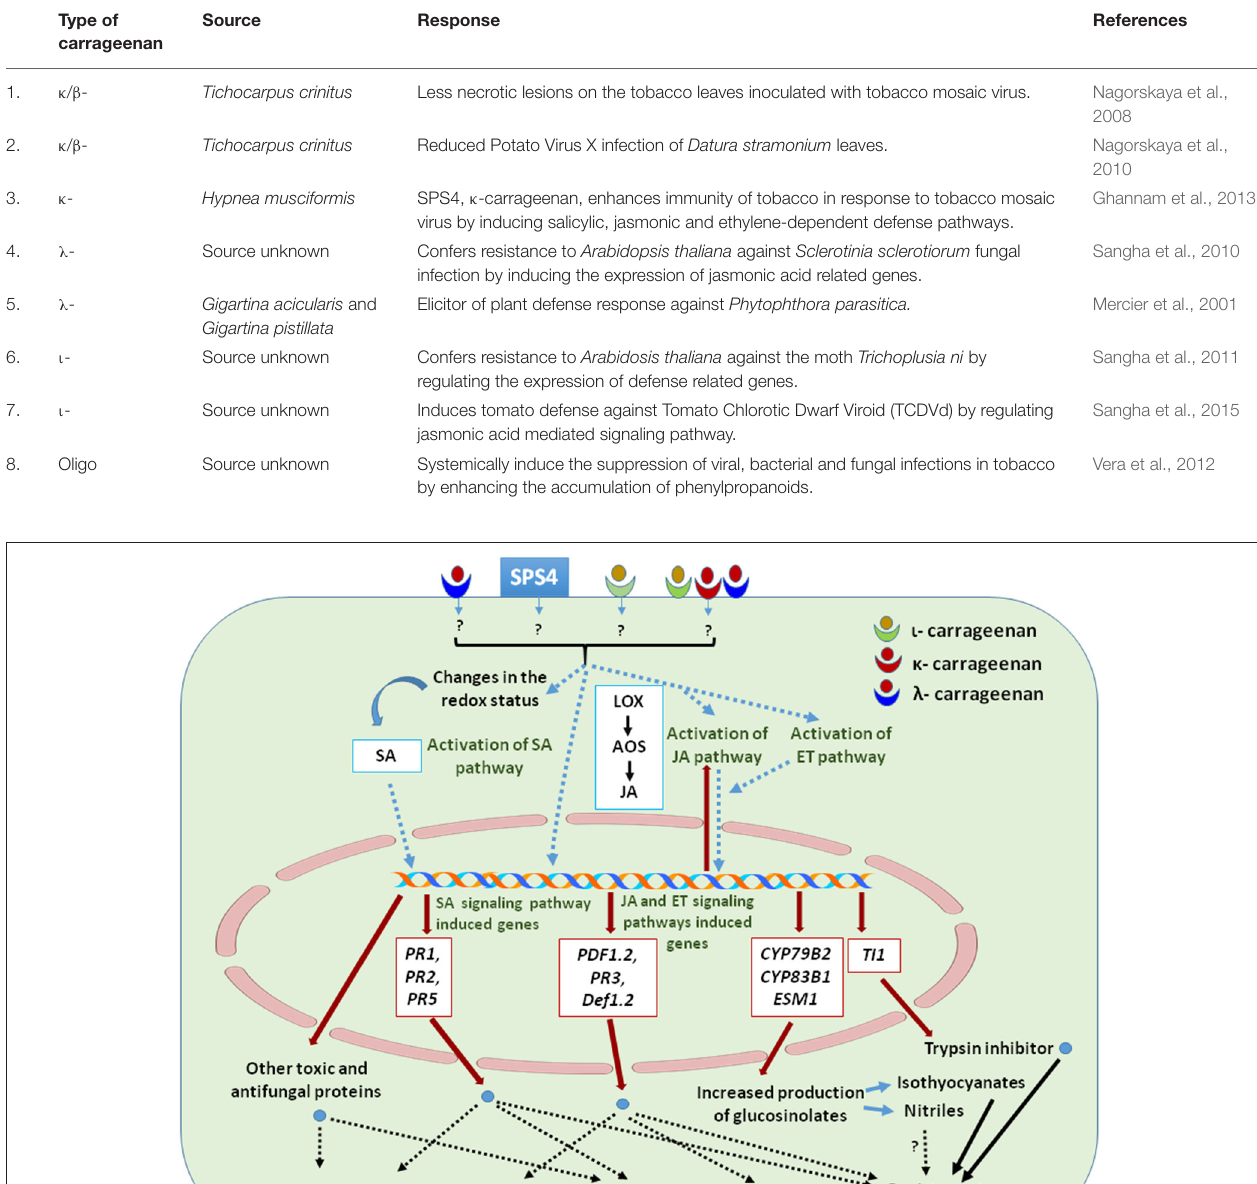
Frontiers in Marine Science |